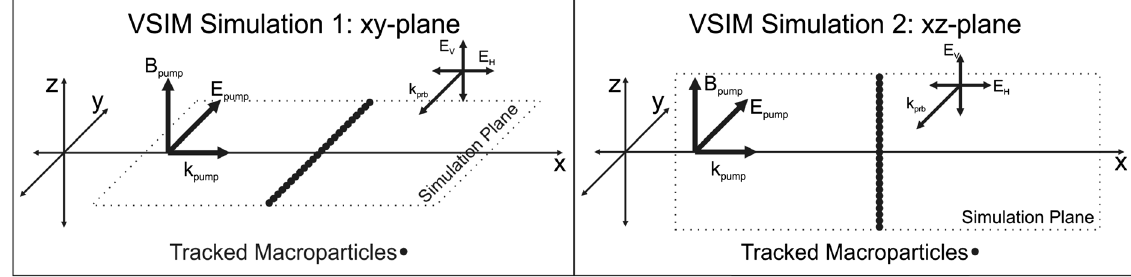
FIG. 6. Setup of the two 2D VS im simulations.